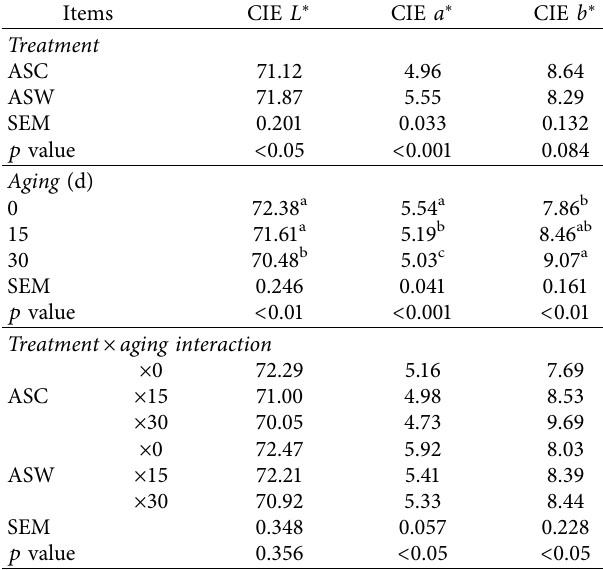
RC, raw control diet pork loin; RW, raw whey-fed pork loin. SEM: standard error of the mean. a, b Means within a row with different letters are sig- nificantly different ( p < 0 . 05). Table 5: Color of dry-aged, sous vide-cooked pork loin in pigs fed a whey powder-supplemented